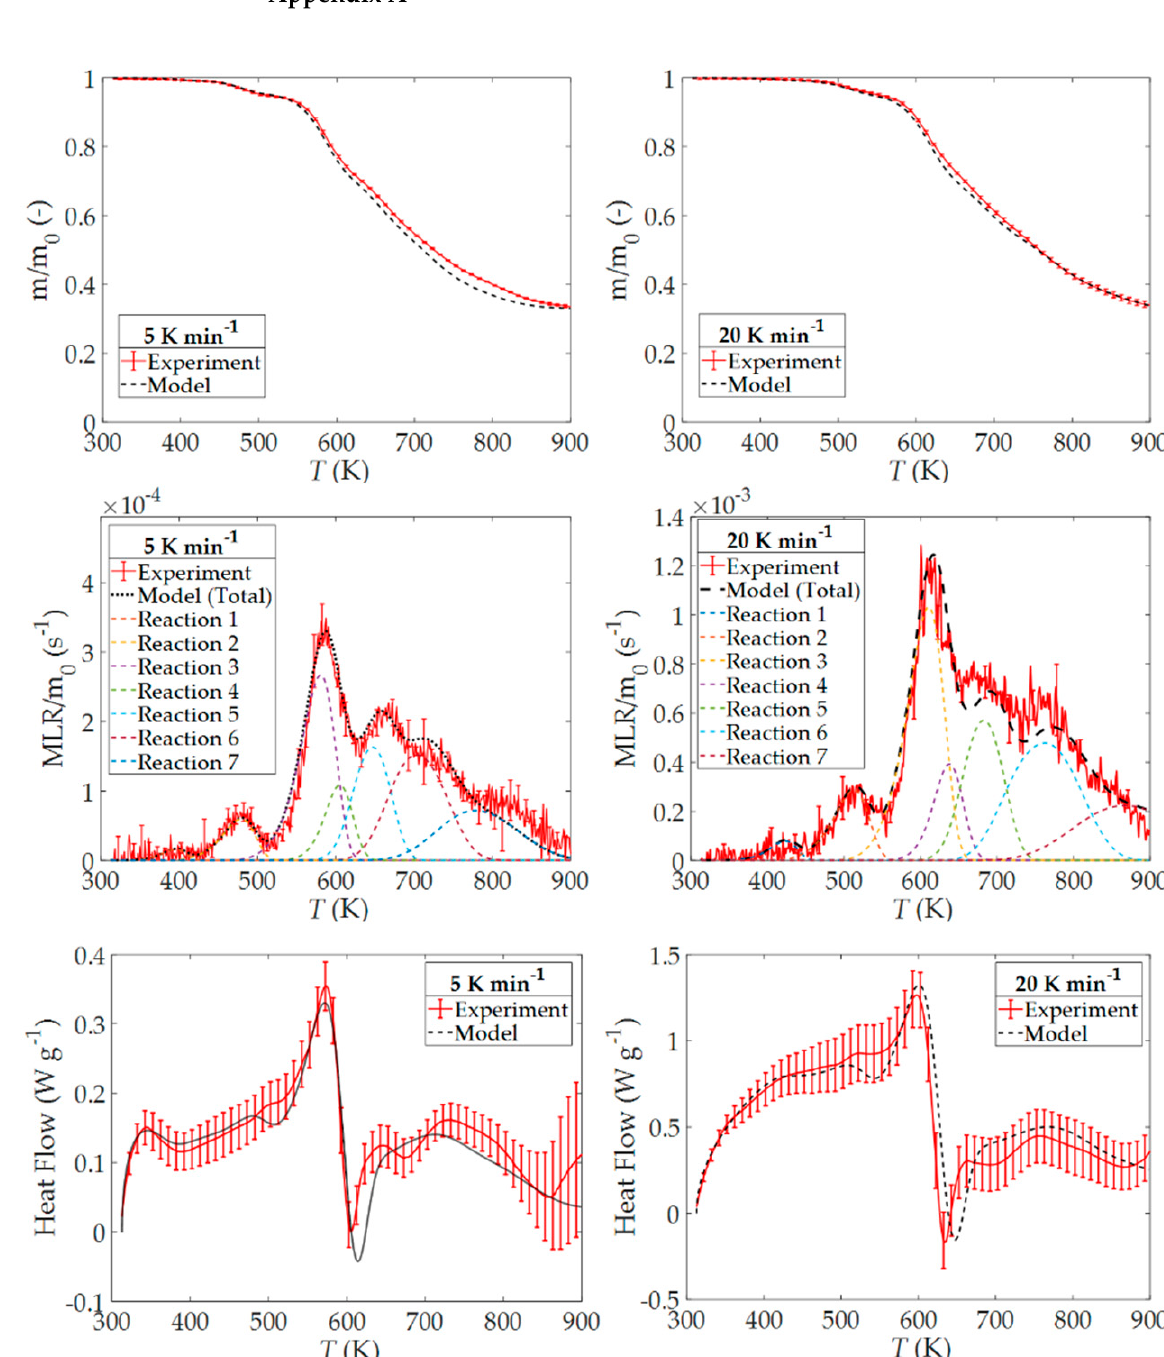
Figure A1. Mean experimental results and model predictions for the TGA and DSC tests performed on the PIR foam at 5 K min − 1 and 20 K min − 1 in nitrogen.